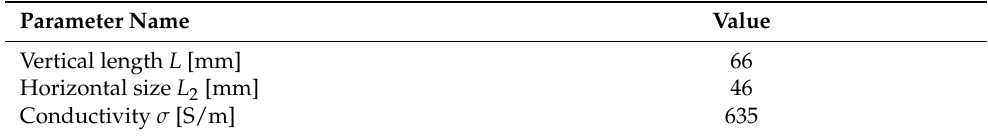
Table 5. Parameters of the designed shield.